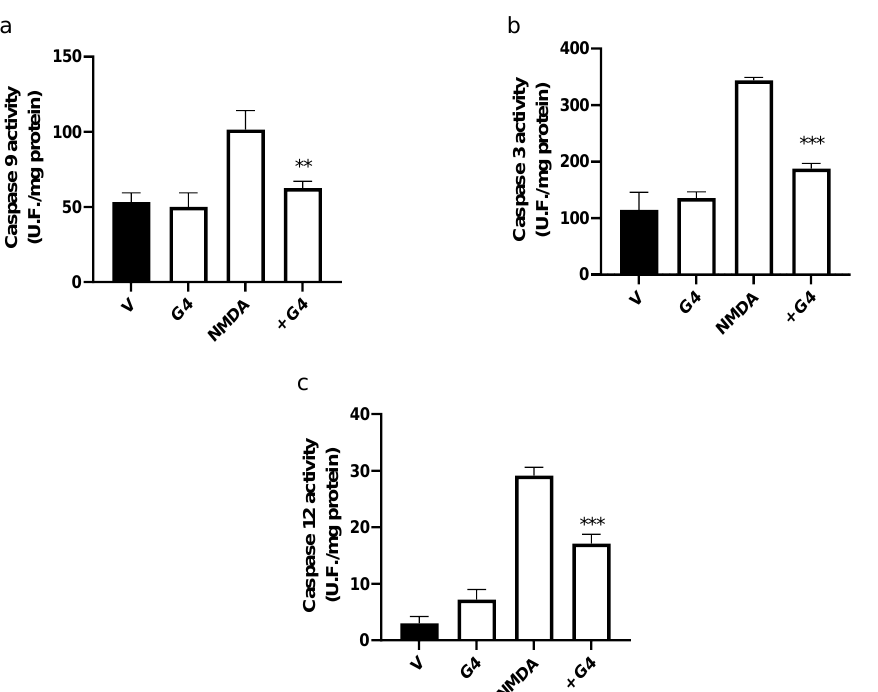
Figure 8. Effect of the phosphorous dendrimer G4 on NMDA-induced ( a ) caspase 9, ( b ) caspase 3, and ( c ) caspase 12 enzymatic activity in brain organoids. Brain organoids were treated with either vehicle (V) or G4 phosphorous dendrimer (10 µ M) for 1 h, and then NMDA (150 µ M) was added. Caspase 3 and 9 activities were determined at 3 h and caspase 12 at 6 h. Caspase activity was determined in total lysates as described in the Materials and Methods section. The data are expressed as the mean + the s.e.m. of five independent experiments. ** p < 0.01, *** p < 0.001 as compared to NMDA-treated cells in the absence of